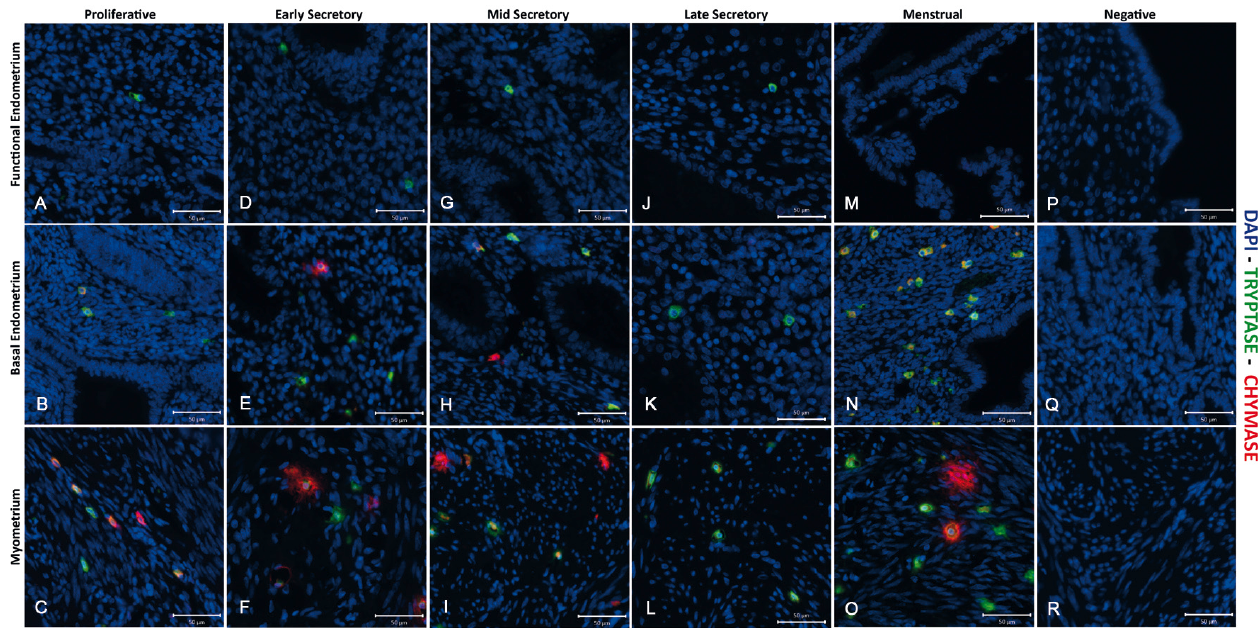
Figure 2. Comparison of immunoexpression of chymase and tryptase in “full thickness” (uterine lumen to endometrial/myometrial junction) tissue samples obtained from across the menstrual cycle. Note that mast cells were less abundant in the functional layer and appeared to be exclusively tryptase+/chymase-. ( A – C ) Functional, basal endometrium and myometrium during proliferative phase (P); ( D – F ) Early secretory phase (ES); ( G – I ) Mid secretory phase (MS); ( J – L ) Late Secretory phase (LS); ( M – O ) Menstrual phase (M); ( P – R ) Negative control (omission of primary antibody). Double immunofluorescence has revealed the presence of three uterine mast cell subtypes, single tryptase, single chymase and double tryptase-chymase positive cells. (P n=4, ES n=4, MS n=2, LS n=3, M n=2): negative controls were included on all